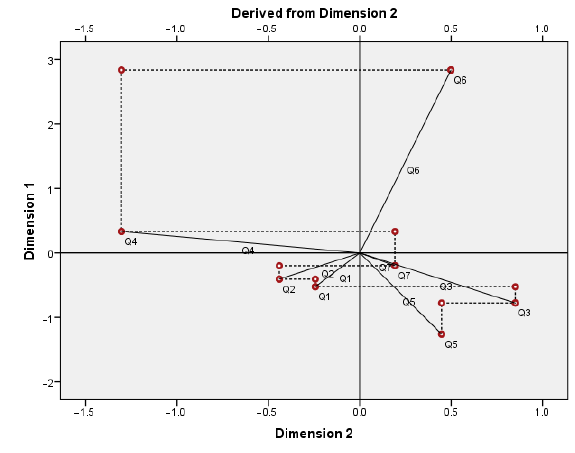
Figure 11. Proximity matrix (Euclidean distance between